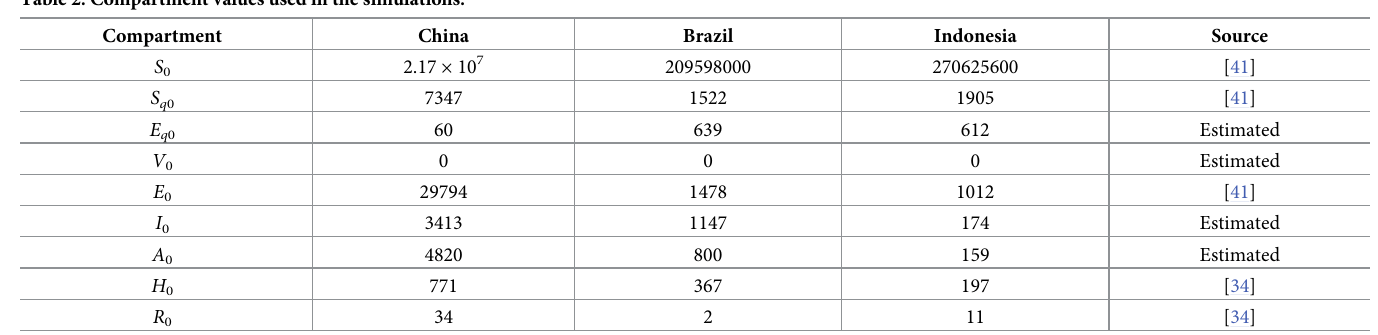
Table 2. Compartment values used in the simulations.